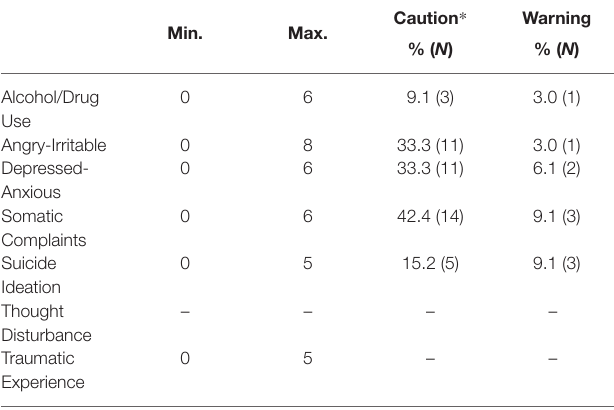
TABLE 2 | MAYSI Descriptives for female JSO.